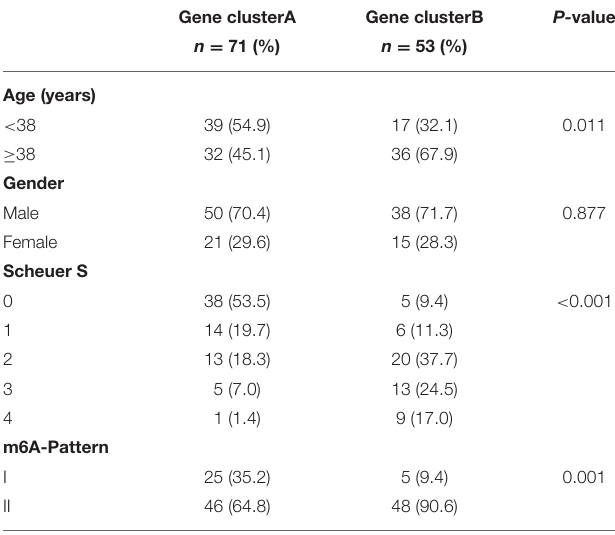
TABLE 2 | Age, gender, Scheuer score (S), and m6A-Pattern of both gene clusters. Gene clusterA Gene